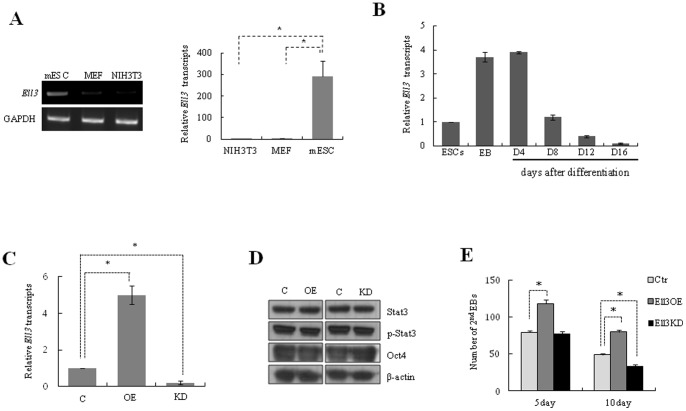

Ell3 is specifically expressed in mESCs.(A) RT-PCR and real-time RT-PCR analysis shows that Ell3 is expressed in mESCs but not in MEF and NIH3T3 cells. (B) Quantitative RT-PCR analysis of Ell3 in ESCs, EBs, and differentiated cell stages (RA-D4, RA-D8, RA-D12 and RA-D16). Ell3 transcripts increased at the EB and RA-D4 stages, and subsequently decreased as differentiation progressed (RA-D8, RA-D12 and RA-D16). (C) Ell3 transcript levels in Ell3-OE and KD cells at passage 10 were compared with those in control cells. Passage was counted after Ell3-OE and KD stable cell lines were established. (D) Expression of Stat3, p-Stat3, and Oct4 in Ell3-OE and KD cells was compared with that in control mESCs. β-actin was used as a loading control for immunoblot analysis. (E) Primary EBs of Ell3-OE, Ell3-KD, and control mESCs were dissociated into single cells and re-seeded at a density of 1×106 cells/mL in the same medium. The number of secondary EBs was counted under a bright microscope (n>3). All experiments were performed at least in triplicate, and all values represent the mean ± s.d. from at least triplicate experiments. *Indicates significant (P<0.05) results (Student's t-test).